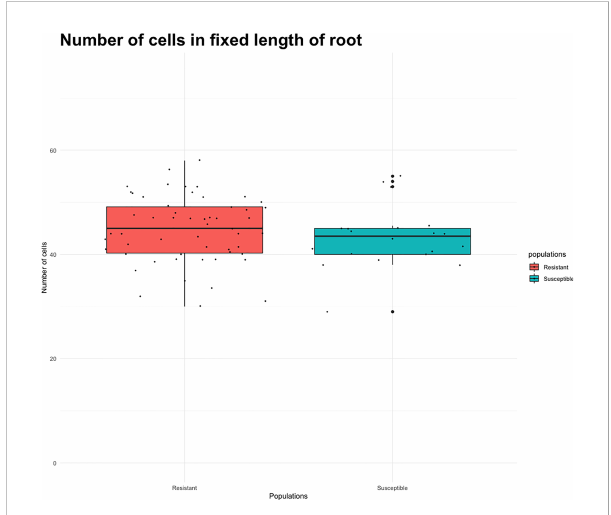
FIGURE 2 Root cell count data from indazi fl am-resistant (Sites 3A, 3B, S18, FL)